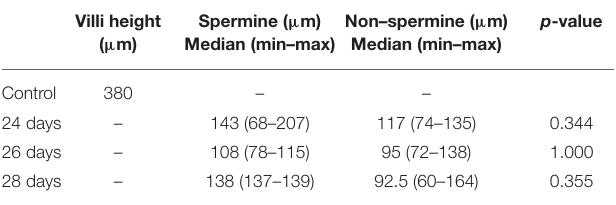
TABLE 1 | Ileal villi height in spermine and non–spermine treated